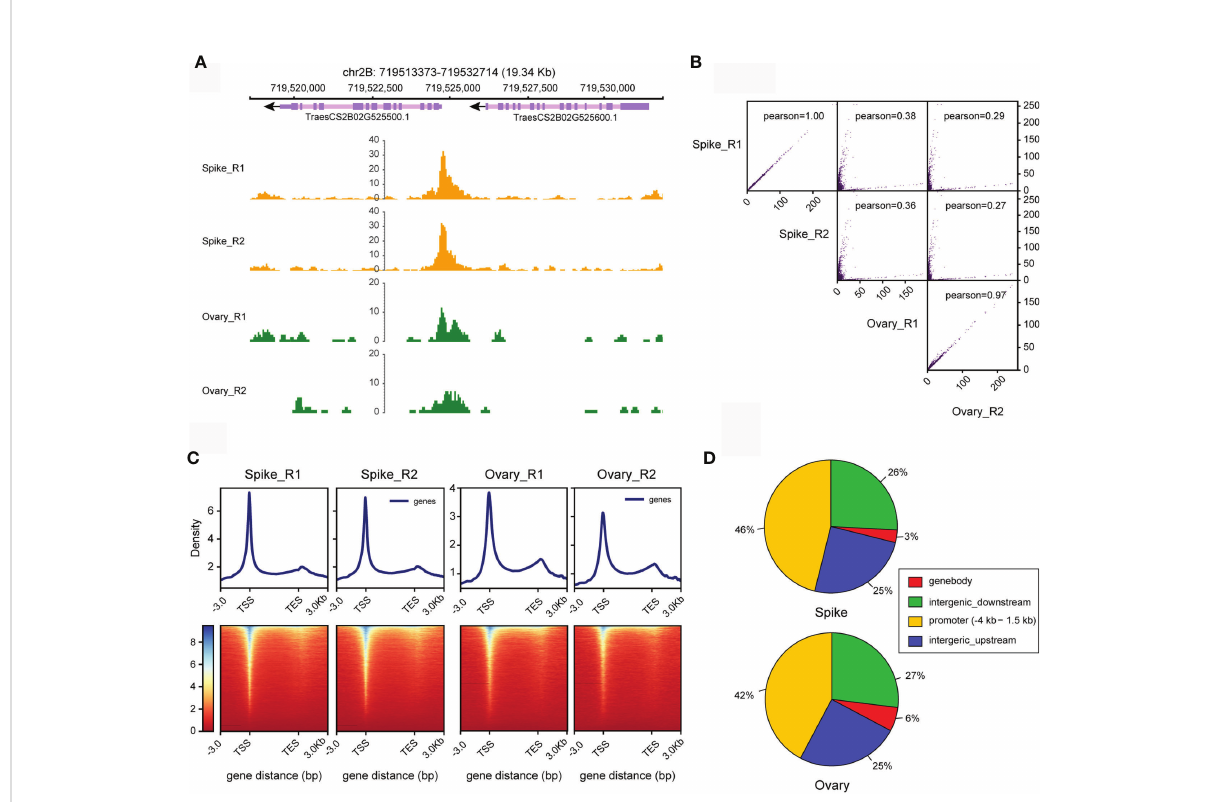
FIGURE 5 Estimation of the quality of ATAC-seq data from young spike and ovary. (A) Visualizing ATAC-seq data for young spike and ovary via IGV. (B) Scatter plot of the correlations between replicates. The Pearson correlation coef fi cient was calculated. (C) Distribution frequency of open chromatin regions in young spike and ovary at TSS and TES. (D) Proportions of distribution of open chromatin regions in the genome in young spike and